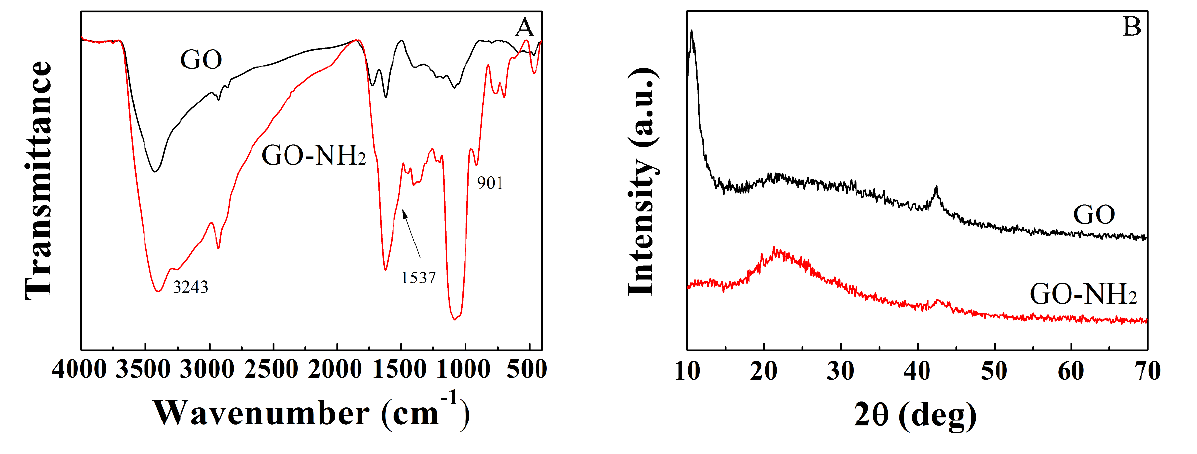
; (B) XRD patterns of GO and GO-NH 2